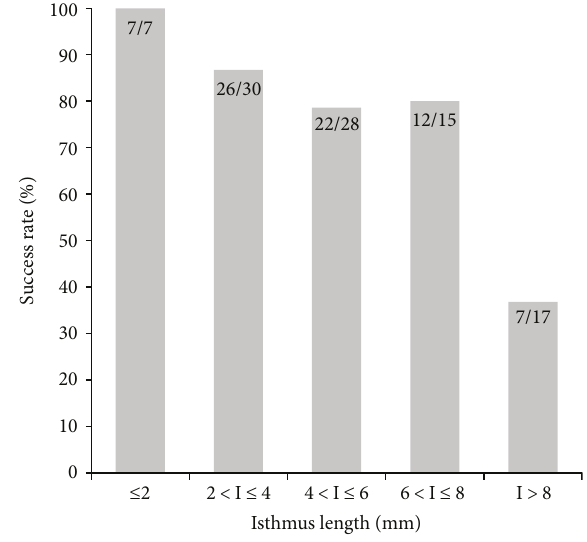
Figure 2: Success rates of radioactive iodine therapy for various isthmus length subgroups in patients with Graves ’ disease. Data are presented as number of patients with treatment success/total